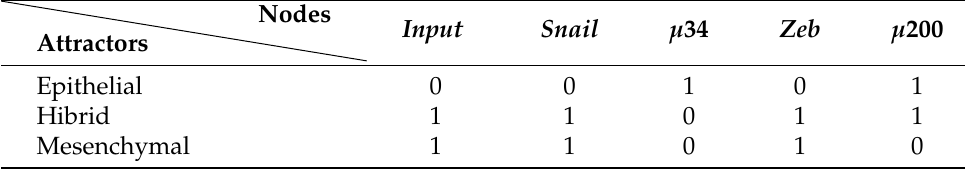
Table 4. Relationship between attractors and cell states in the